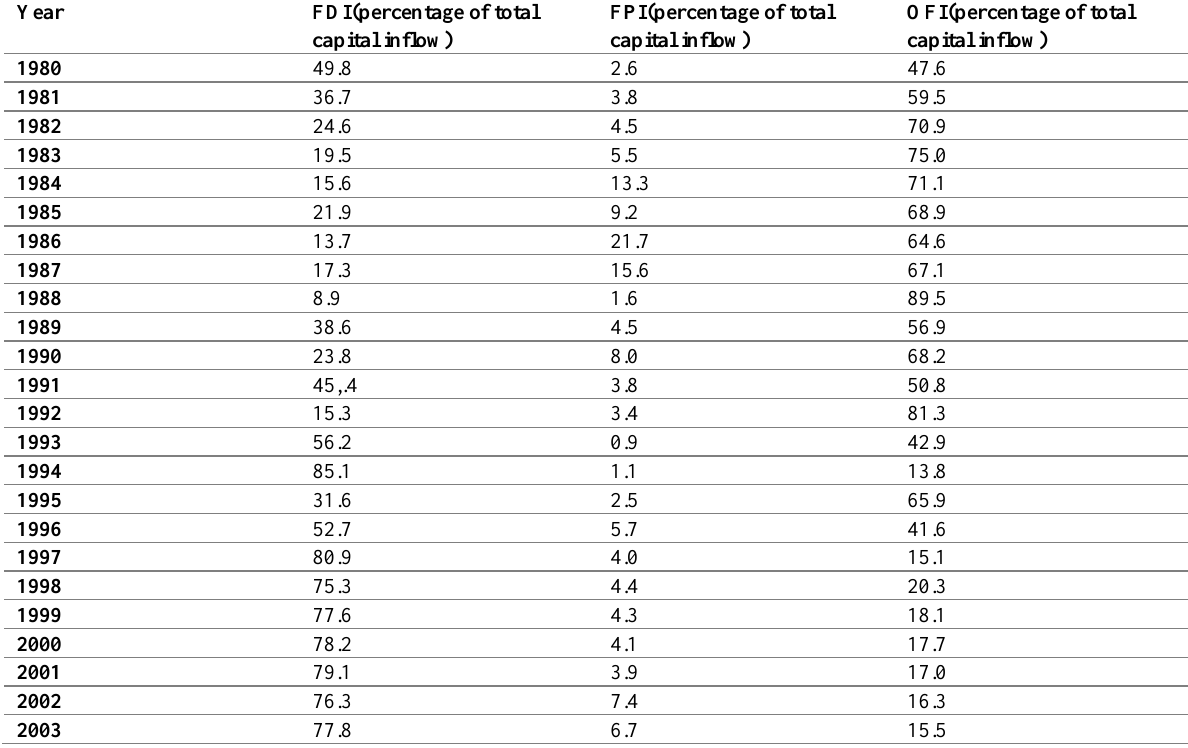
Table 1: Capital inflow in Nigeria, 1980—2003